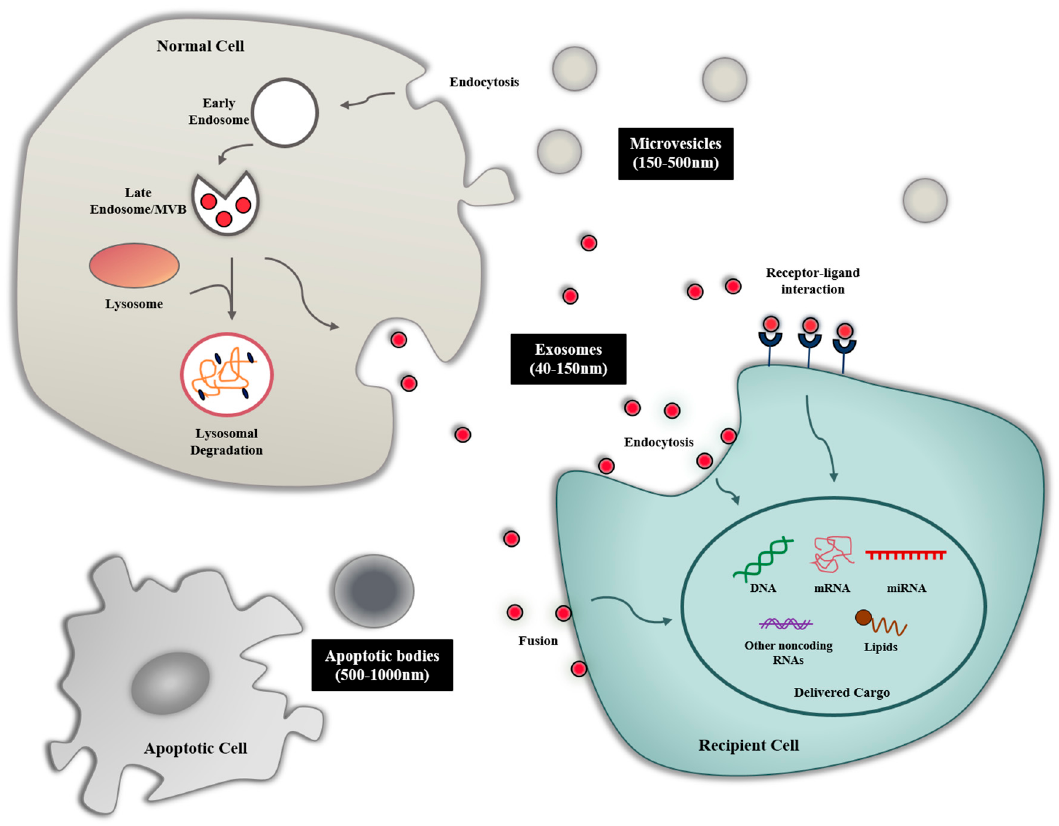
Figure 1. Biogenesis and uptake mechanisms of exosomes. Early endosomes generated through invagination of the plasma membrane form multivesicular bodies (MVB) through inward budding, which releases exosomes through the exocytosis. Released exosomes can be taken up via different mechanisms: endocytosis, membrane fusion, receptor–ligand interaction.